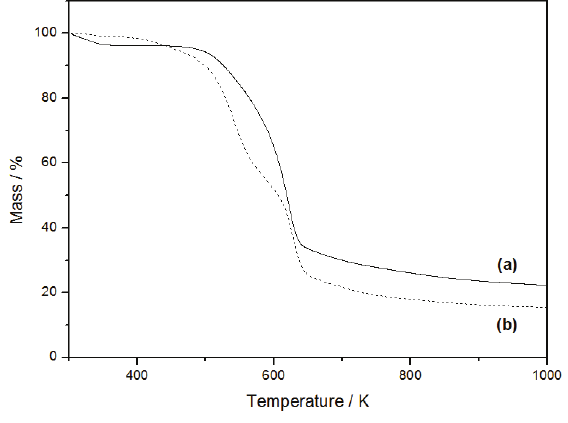
and (b) Influence of pH on the sorption of the Figure 4 - (a) pH zpc VR 5 dye by wood sawdust modified with succinic anhydride,